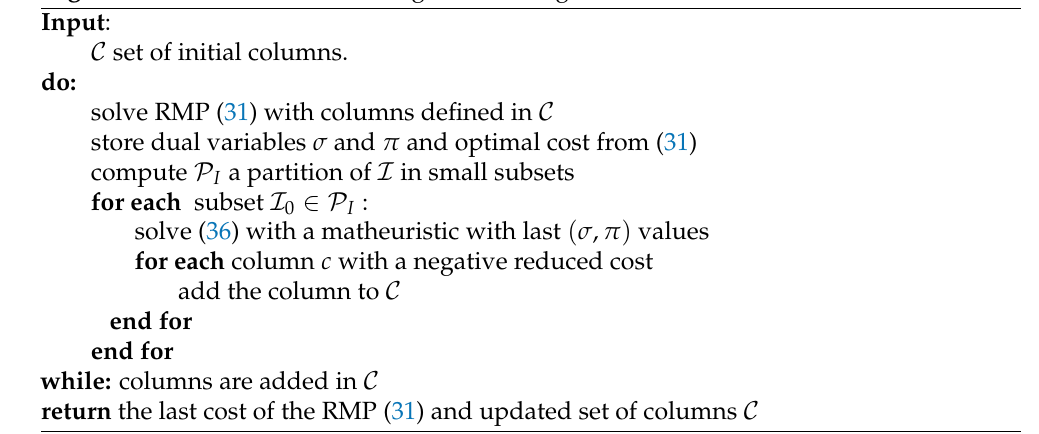
Algorithm 6 POPMUSIC column generation